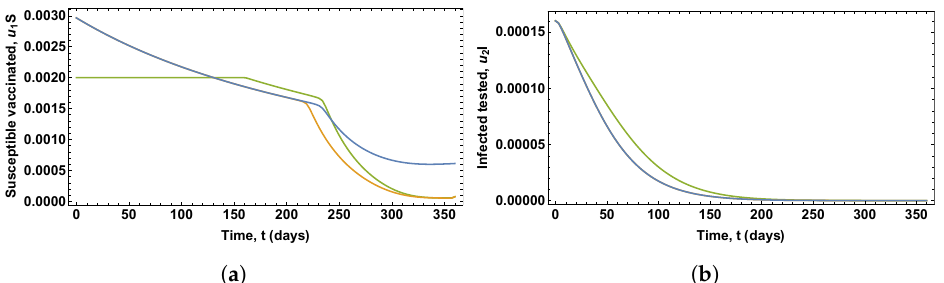
Figure 5. Optimal proportions of vaccinated and tested people for scenario 1 (blue), scenario 2 (orange), and scenario 3 (green): ( a ) Optimal proportion of susceptible vaccinated people. ( b ) Optimal proportion of infected tested